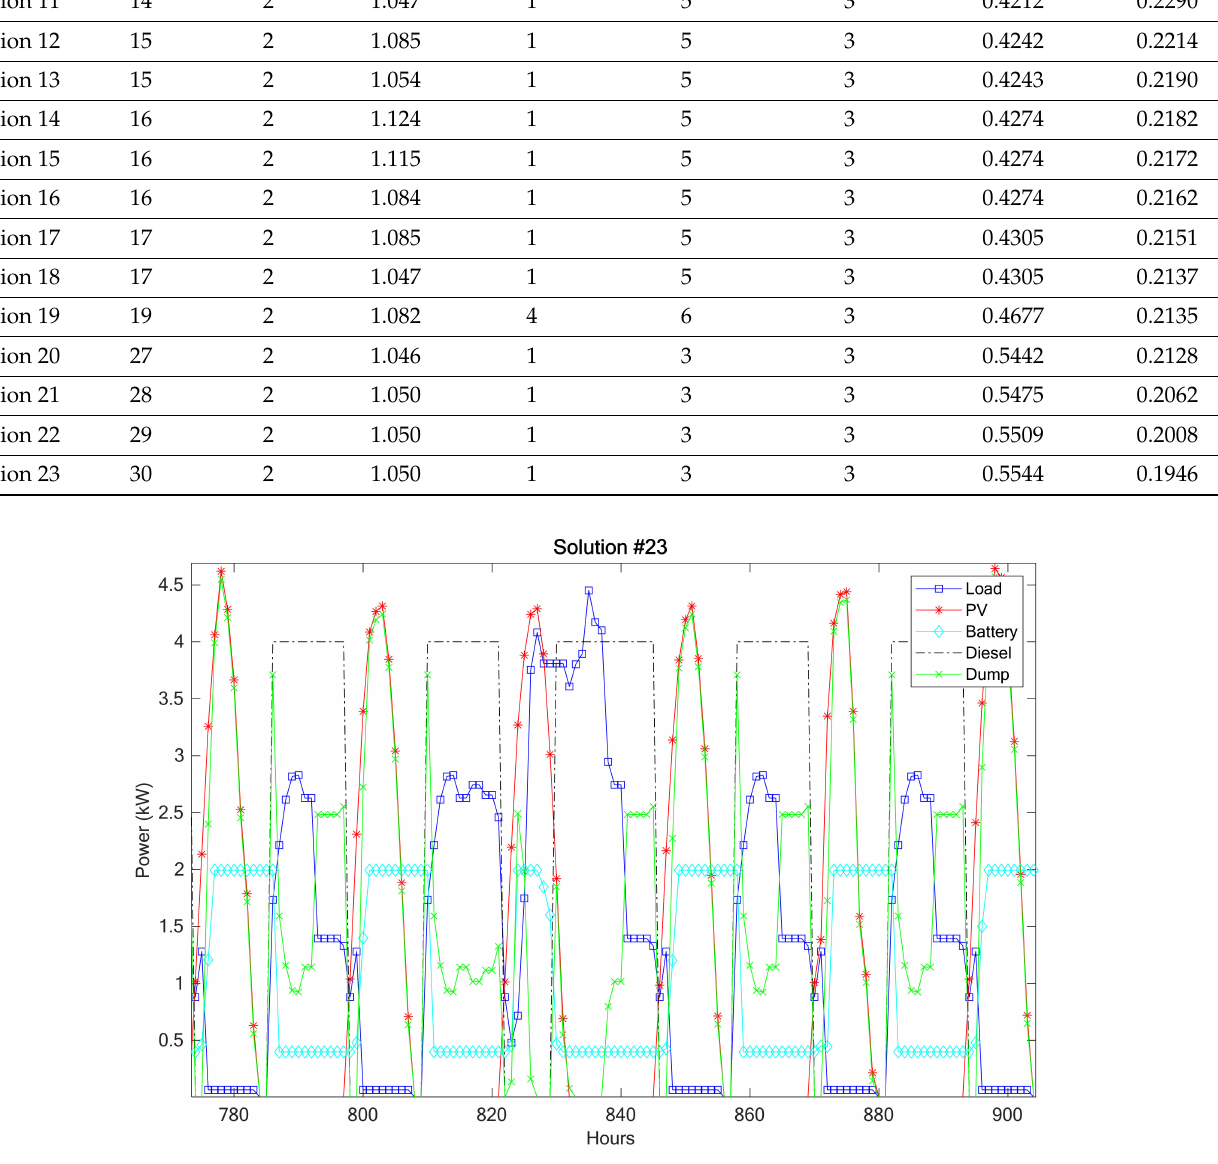
Figure 8. Zoom on the energy contribution of each component for solution